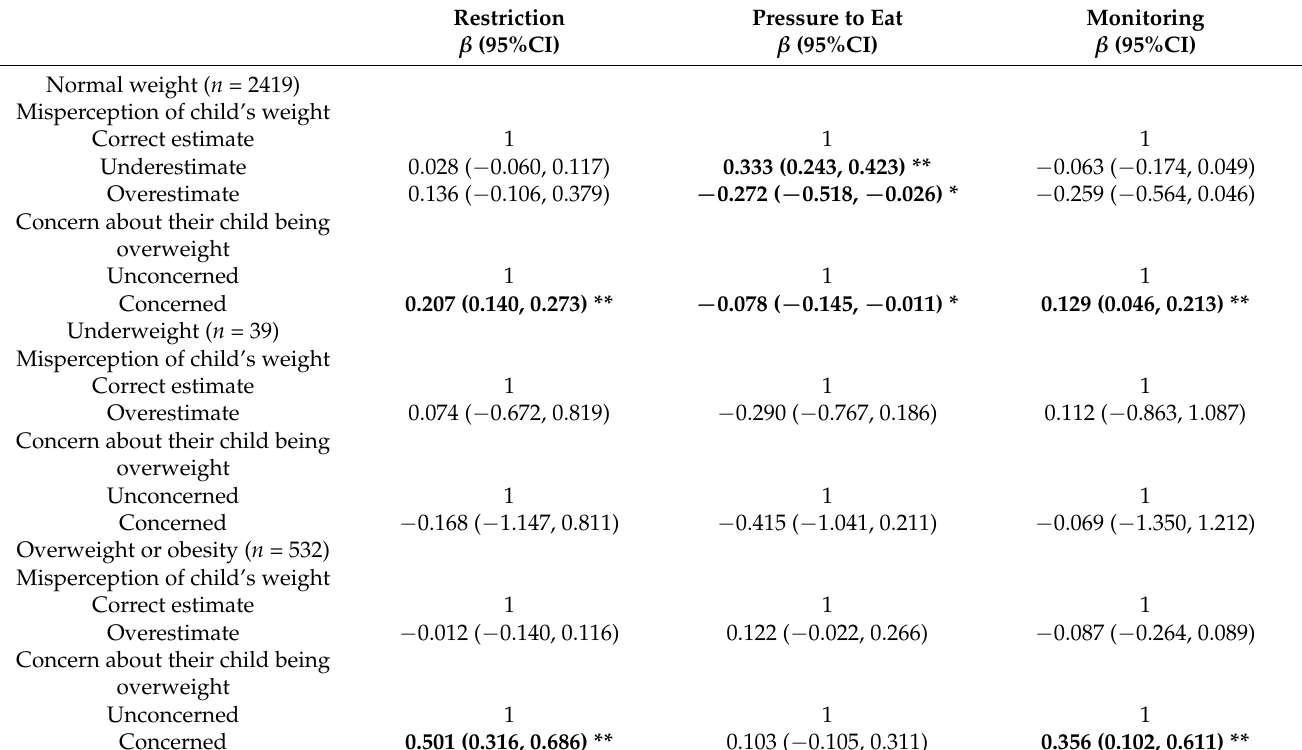
Table 3. Linear regression relationships between parents’ weight perceptions, concerns, and feeding practices among different weight statuses of children.